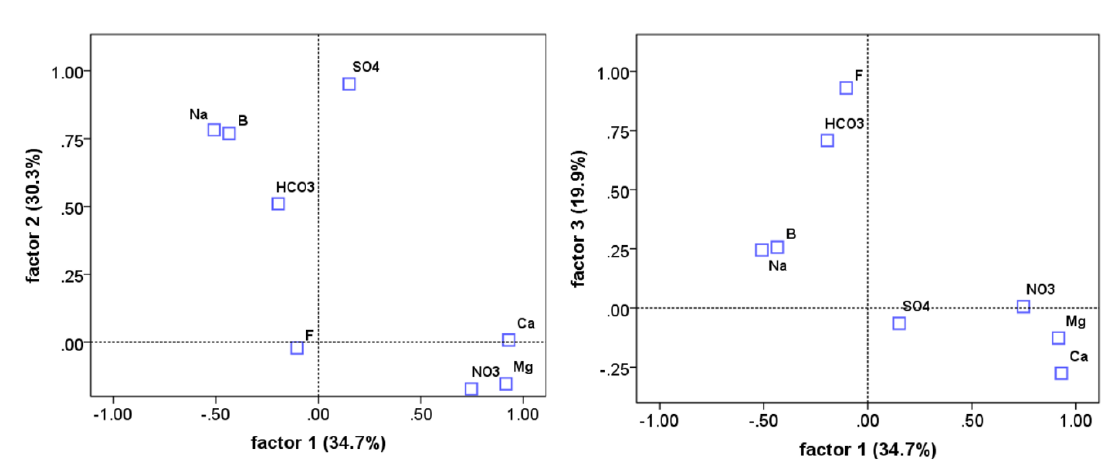
Figure 10. Water quality consistent loadings on factors 1, 2, and 3. Extraction by principal component anlaysis and Varimax rotation. Total variance explained is 84.9% and all consituent communalities are 0.800 or better except for nitrate which has a communality of